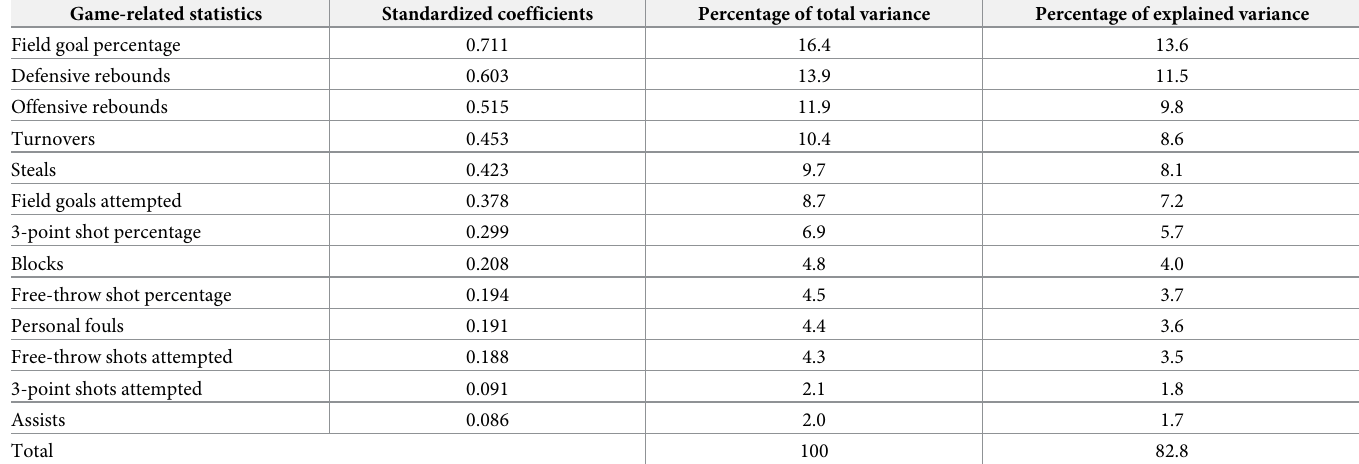
Table 5. Standardized discriminant function coefficients and percentage of explained and total variance for game-related statistical parameters during the regular season competitive period.